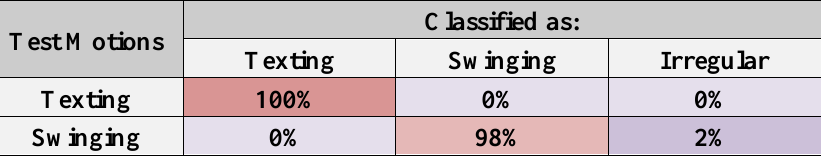
Table 1. Confusion Matrix for the motion mode